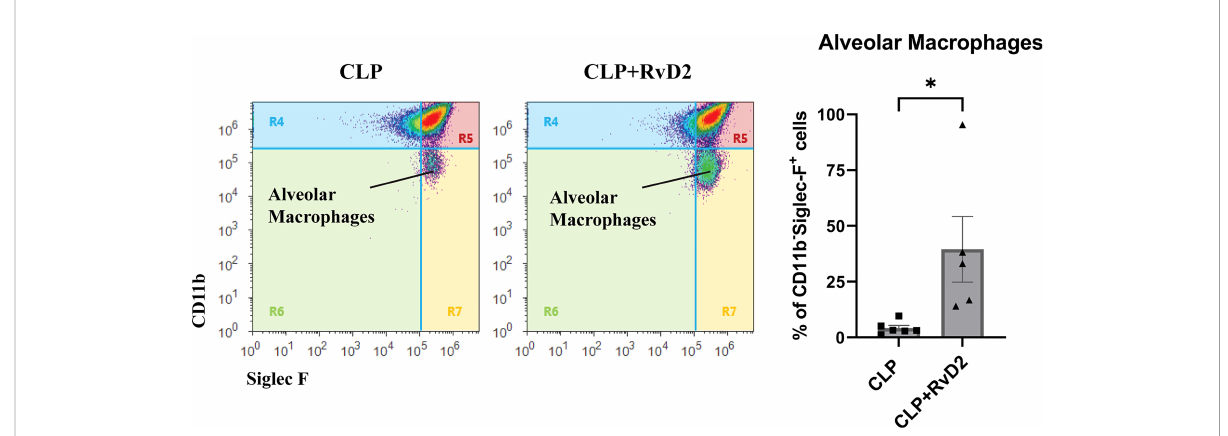
FIGURE 8 CLP surgery was performed on mice. Mice were given vehicle saline or RvD2 48h after surgery. 24h after injections, mice were given P. aeruginosa intranasally. 24h after the 2 nd hit of P. aeruginosa , mice were sacri fi ced and lungs were lavaged. Using fl ow cytometry, non- in fl ammatory alveolar macrophages (CD11b - Siglec F + ) were counted in lung lavage. There was an increase in non-in fl ammatory alveolar macrophages in lavage fl uid of RvD2 treated mice. Data are mean ± S.E.M. * P < 0.05 for n = 5 for both